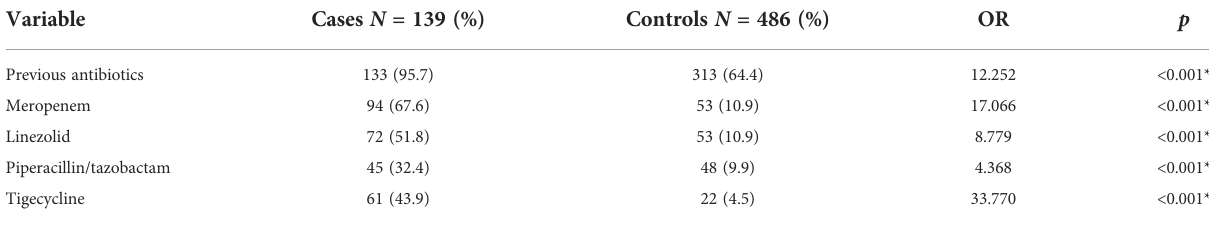
TABLE 2 Previous antibiotics used for patients infected with Klebsiella pneumoniae NDM-1 and controls.